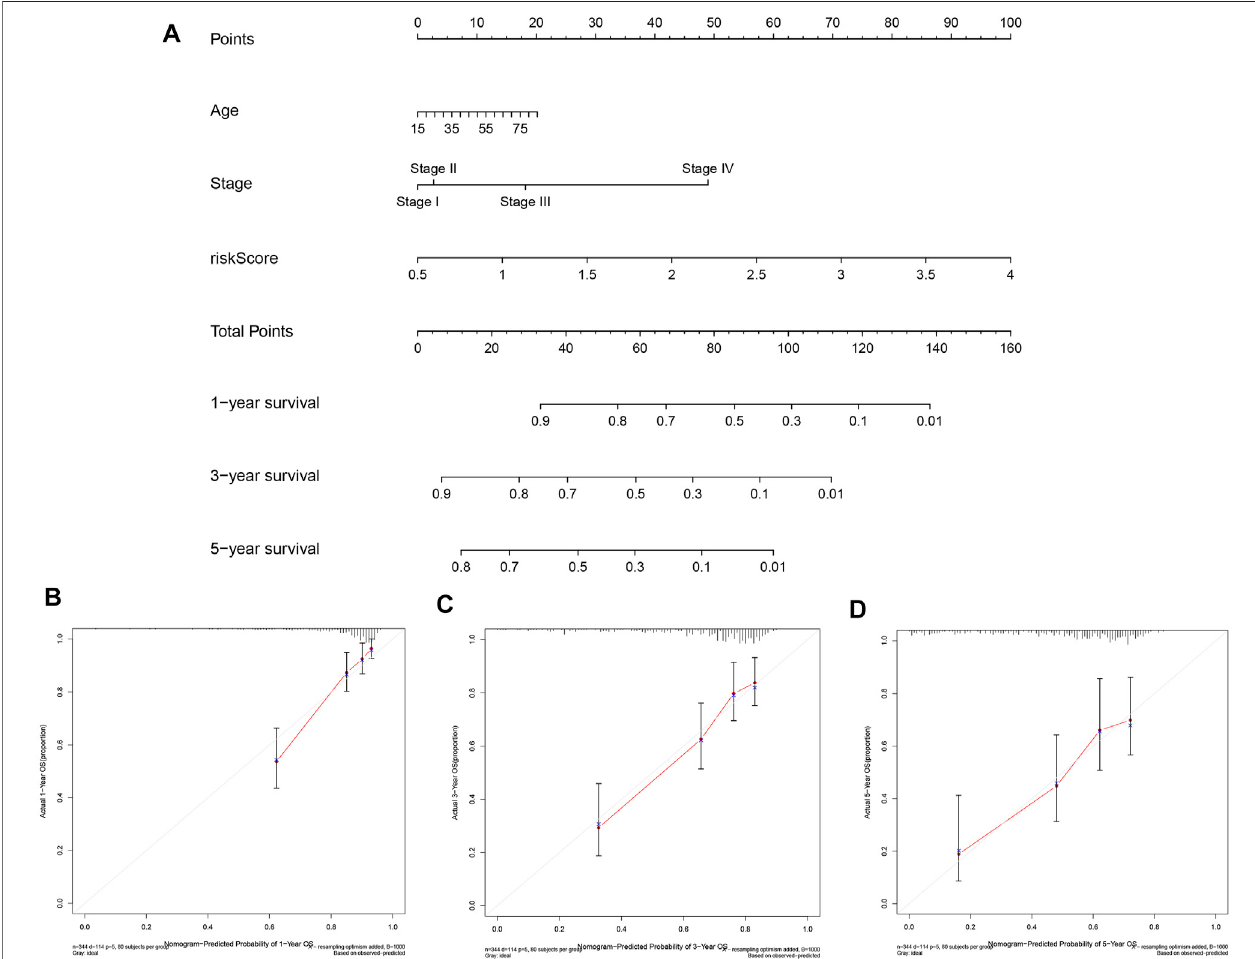
FIGURE 7 | Construction and Validation of the Prognostic Nomogram. (A) Prognostic nomogram for predicting OS probability of patients at 1, 3, 5 years. (B – D) Calibration curves of nomograms for predicting 1, 3, and 5 year survival probability in TCGA cohort.